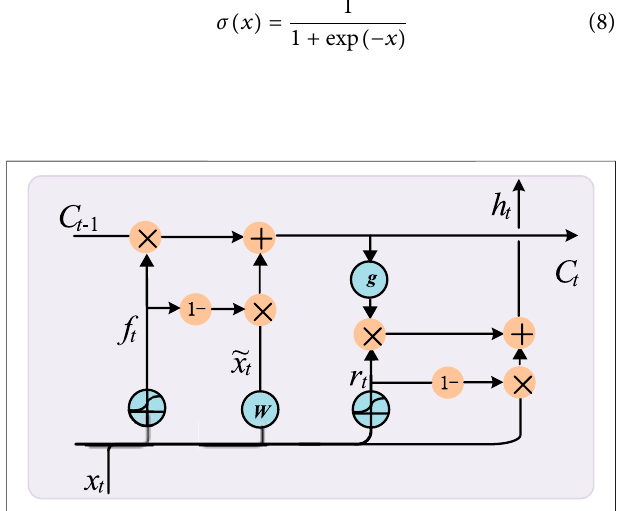
FIGURE 2 | Schematic diagram of an